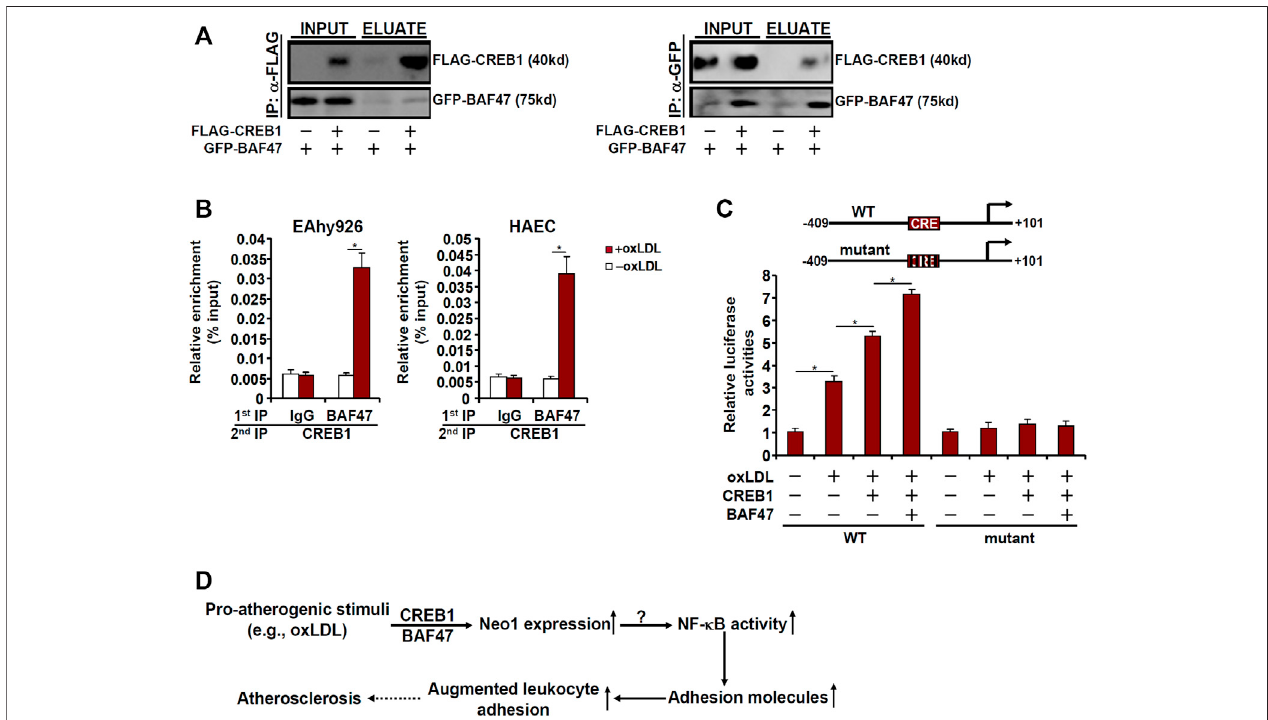
FIGURE 6 | CREB1 interacts with and recruits BAF47 to activate Neo-1 transcription. (A) HEK293 cells were transfected with FLAG-tagged CREB1 and GFP- tagged BAF47 as indicated. Immunoprecipitation was performed with anti-FLAG or anti-GFP. (B) EAhy926 cells and HAECs were treated with or without with oxLDL (50 μ g/ml) for 24 h. Re-ChIP assay was performed with indicated antibodies. (C) Wild type or mutant Neo1 promoter-luciferase construct ( − 409/+101) was transfected into EAhy926 cells with indicated expression constructs followed by treatment with oxLDL (50 μ g/ml) for 24 h. Luciferase activities were normalized by protein concentration and GFP fl uorescence. (D) A schematic